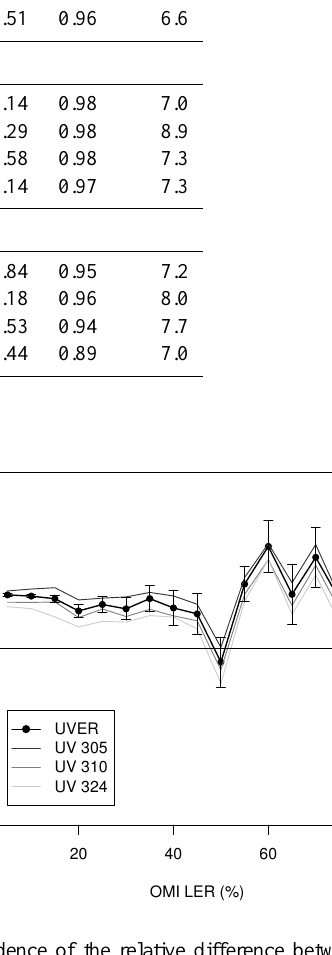
Fig. 2. Dependence of the relative difference between OMI and Brewer UV products with respect to the OMI Lambertian Equiva- lent Reflectivity (LER) at 360nm for all sky conditions (dataset #1) taking binned data. The size of the bins is